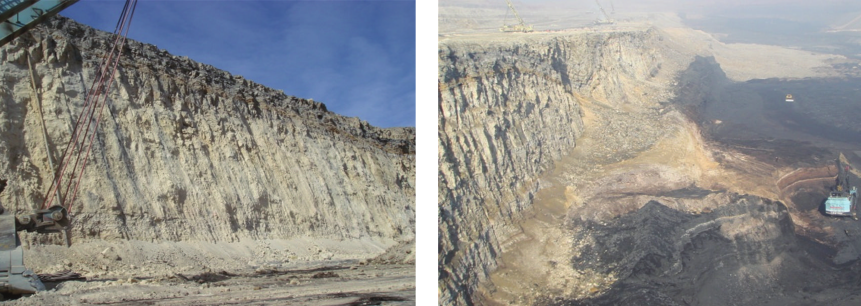
Figure 5: Presplit blasting effect pictures of surface coal mine.